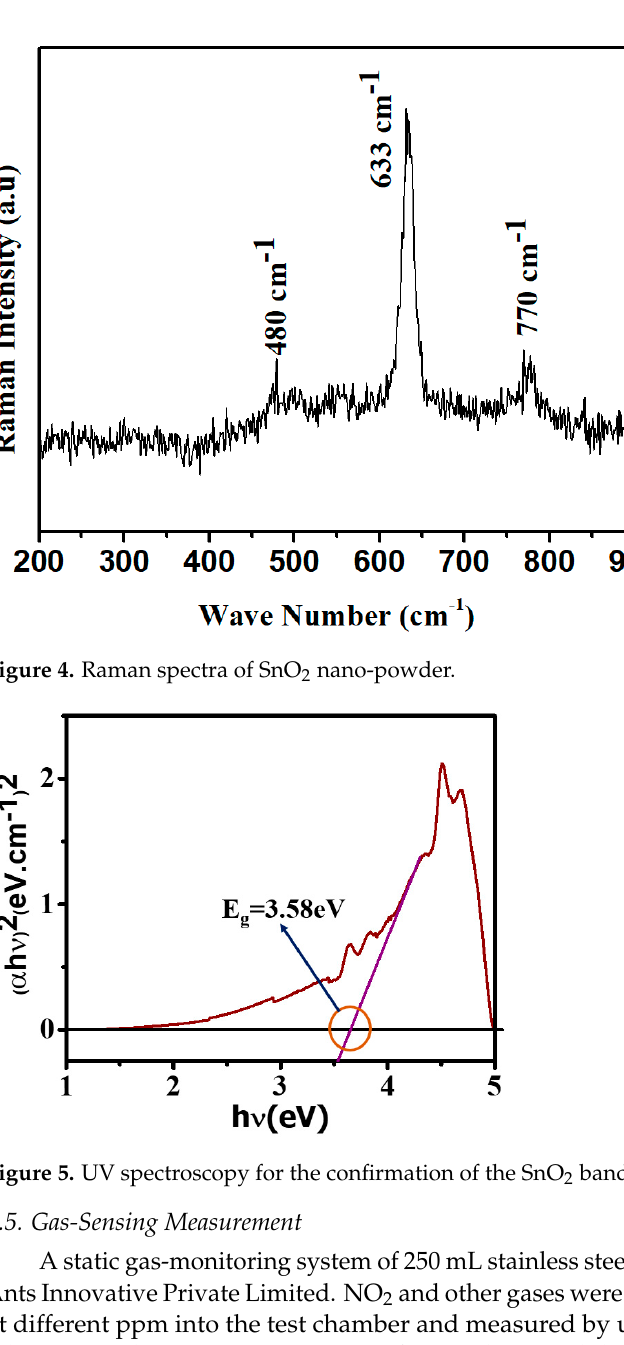
Figure 5. UV spectroscopy for the confirmation of the SnO 2 band gap.